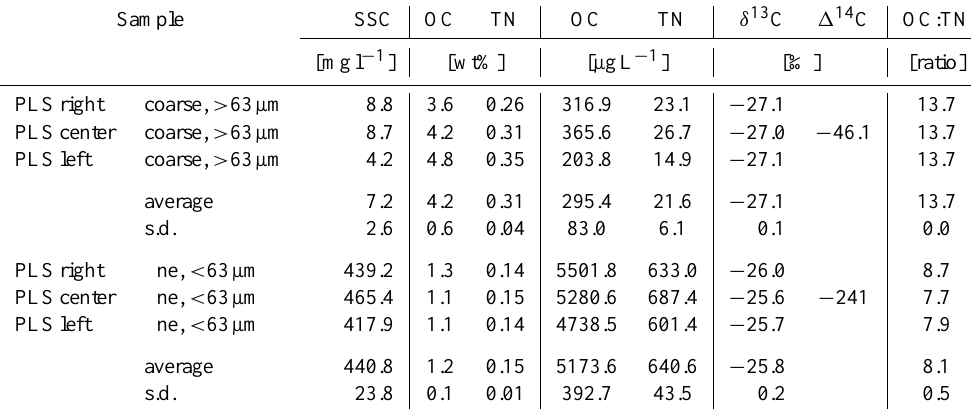
Table 1. Po river samples collected at Pontelagoscuro (PLS).